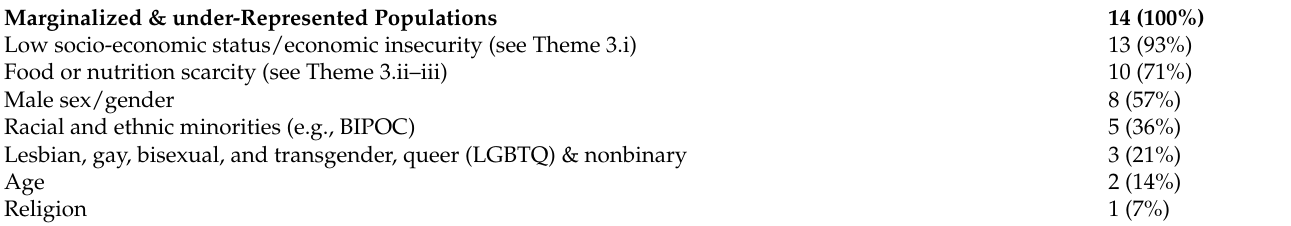
Table 5. Participant responses consistent with Theme 2, “marginalized and under-represented